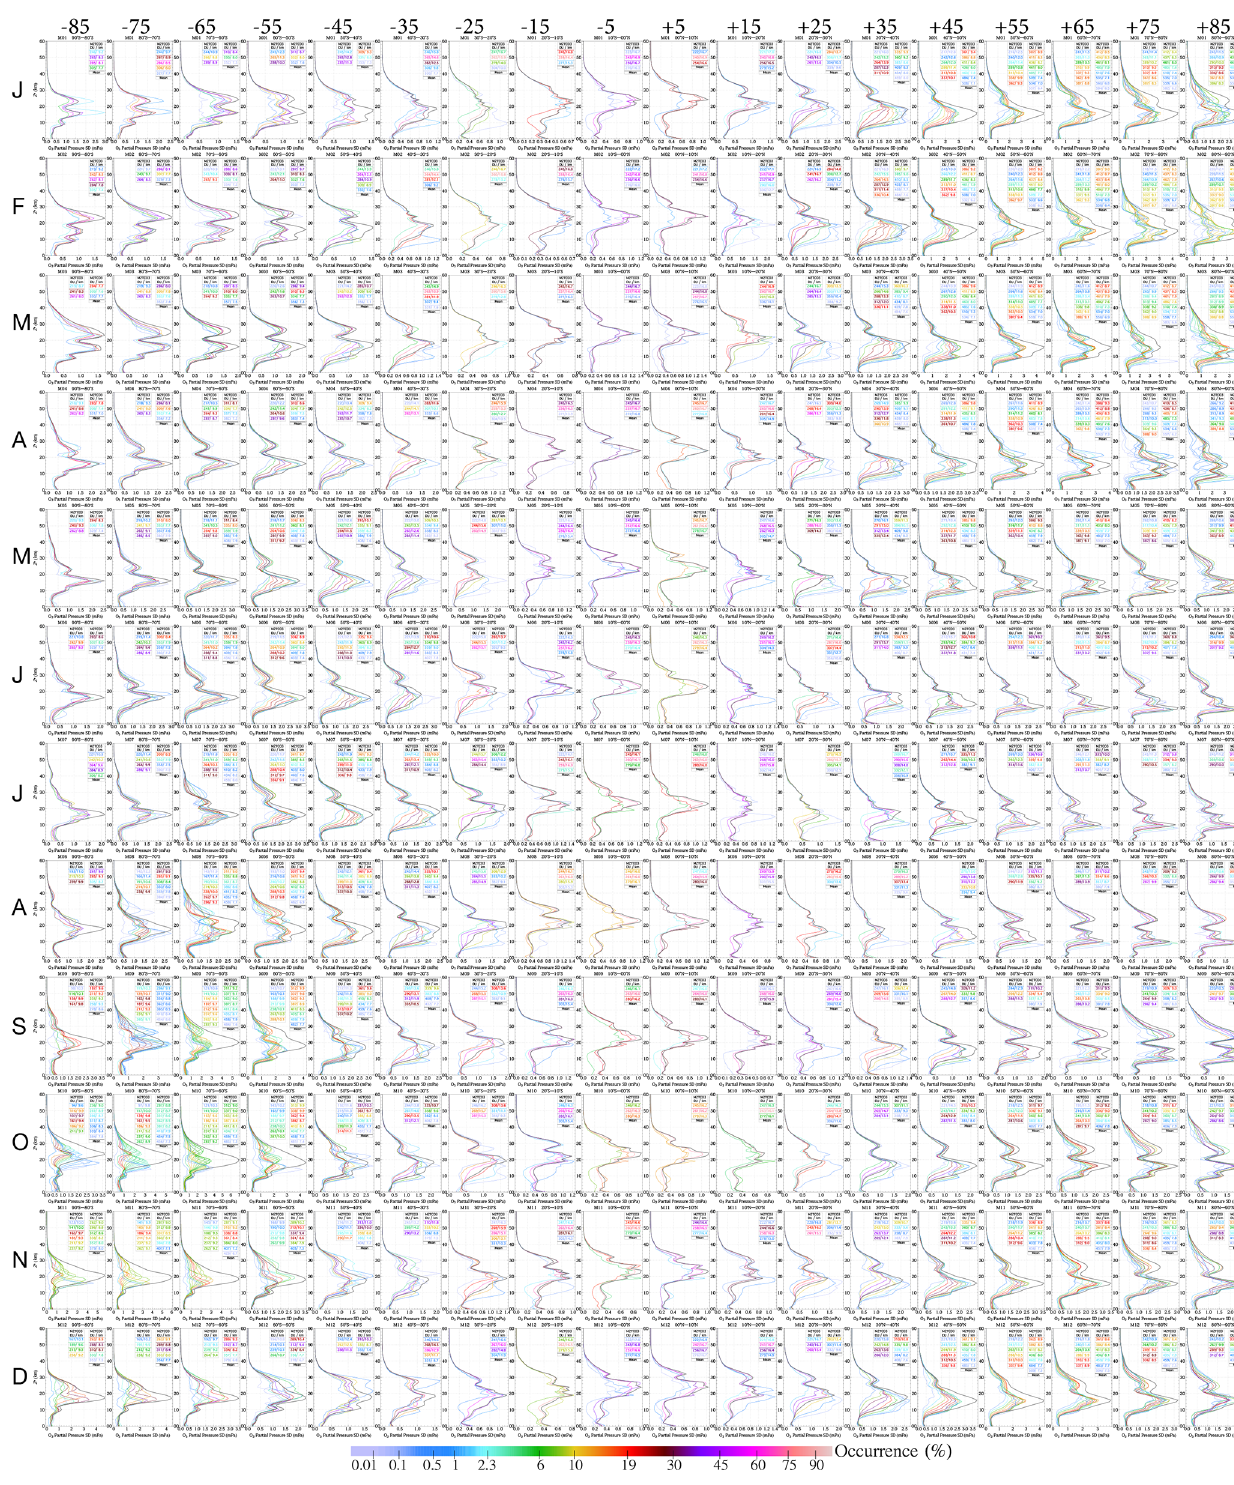
Figure A4. Similar to Fig. A3, except for profile standard deviations in daytime M2TCO3 climatology. This illustrates that total O 3 column classification in general reduces the variability of the climatological